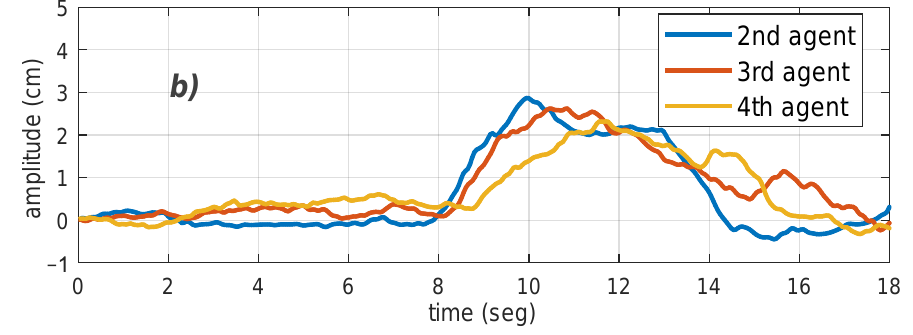
Figure 13. Experimental results for a four agents platoon, starting from rest to a constant speed. ( a ) Followers tracking errors for a string unstable scenario. ( b ) Followers tracking errors for a string stable scenario with time-headway